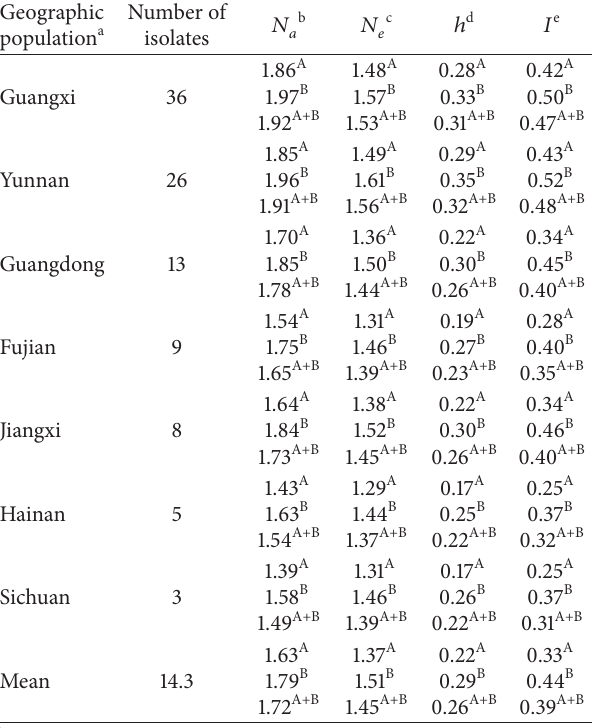
A Genetic diversity of the 100 S. scitamineum isolates based on ISSR markers. B Genetic diversity of the 100 S. scitamineum isolates based on SP-SRAP markers. A+B Genetic diversity of the 100 S. scitamineum isolates based on ISSR and SP-SRAP markers. a The 100 S. scitamineum isolates were devided into 7 subpopulations according to their geographic origins. b Mean observed number of alleles. c Mean effective number of alleles. d Mean of Nei’s gene diversity. e Mean of Shannon’s Information